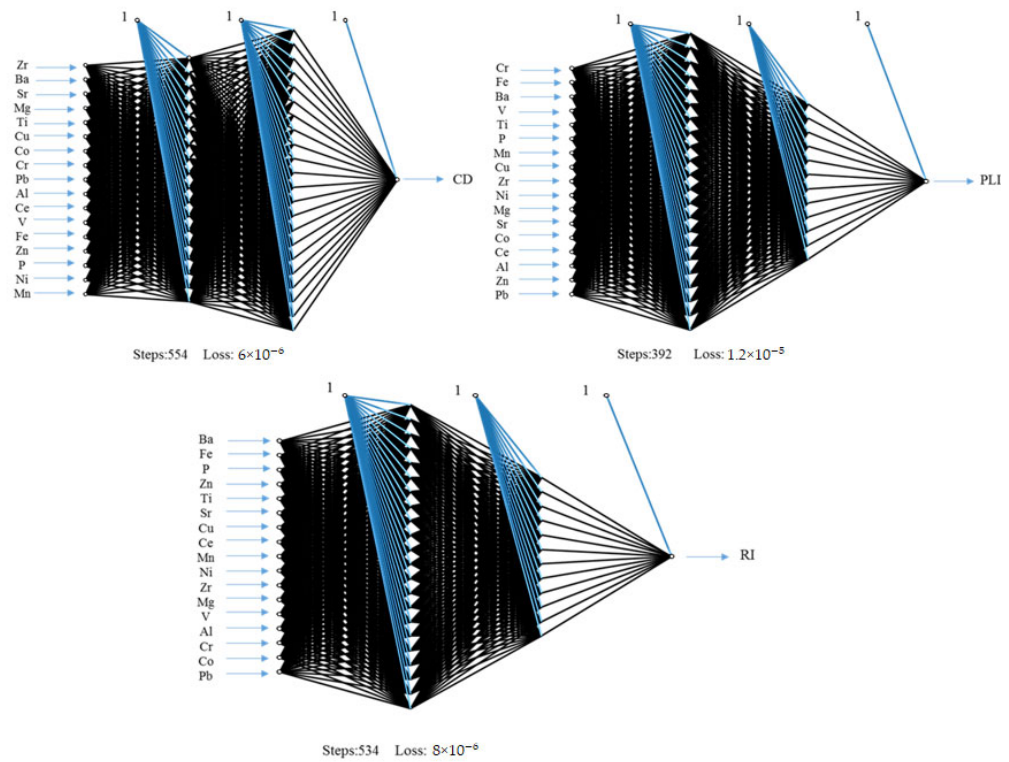
Figure 5. A neural network diagrams established for detecting contamination (CD), pollution load index (PLI), and potential ecological risk index (R1). Table 12. Outcomes of calibration and validation models of ANN of the association between ob ‐ served and predicted for potential ecological risk index (R1), contamination degree (CD), and pol ‐ lution load index (PLI) in the two ‐ year investigation.